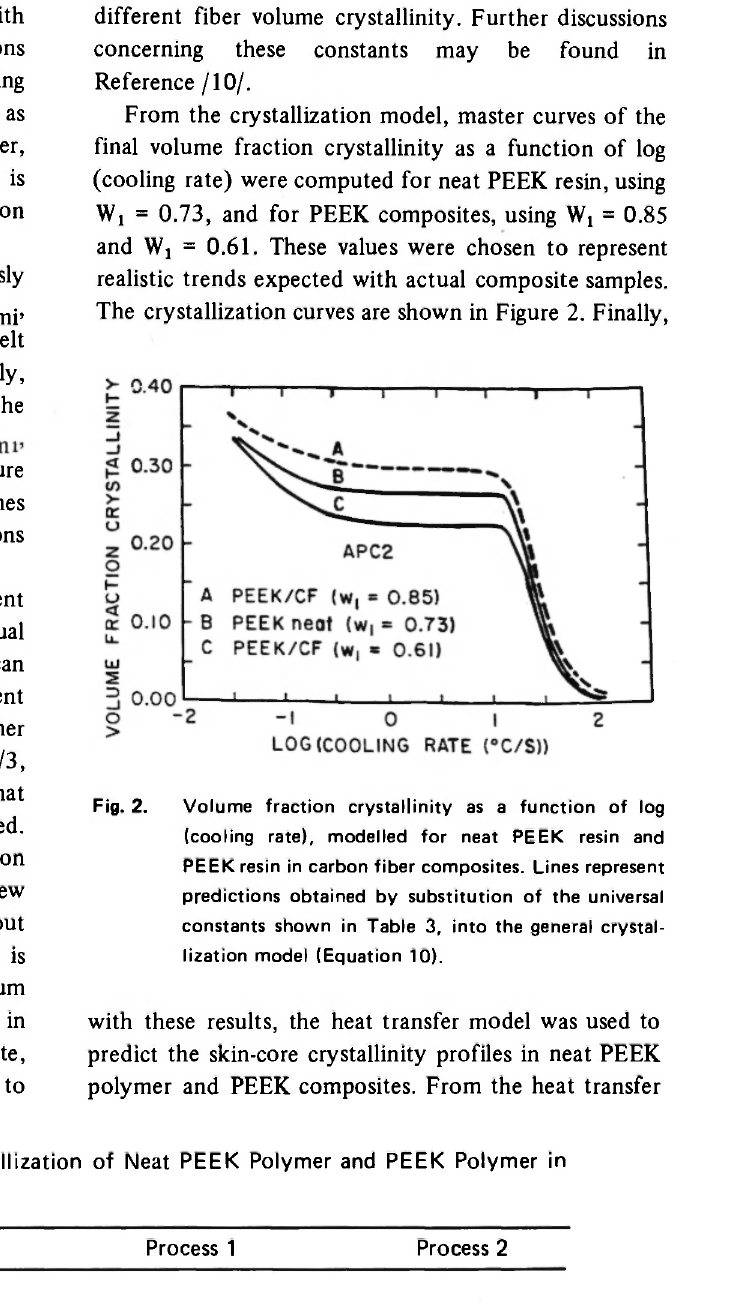
TABLE 3: Model Constants For the Crystallization of Neat PEEK Polymer and PEEK Polymer in the Composite Model